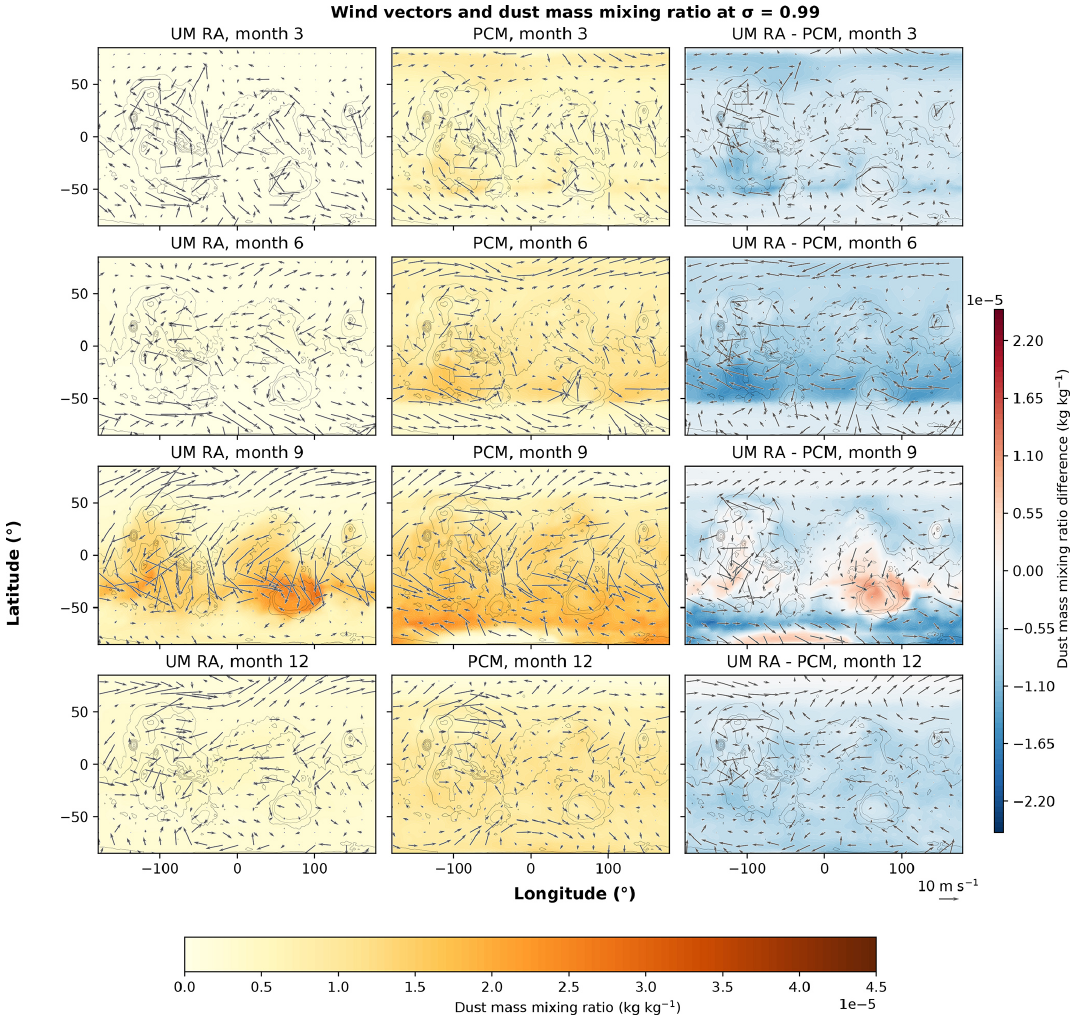
Figure A10. Dust mass mixing ratio (kgkg − 1 ) and horizontal wind speed (ms − 1 ) at σ = 0 . 99 across four seasons within the Martian year; each month is the average taken of all sols within that month (months according to Table A1). The RA dust scenario is shown on the left, the PCM output in the centre and the differences between models on the right. Colour scales in the left-hand and centre plots are matched across all months and between models. The contours in the difference plots are matched across